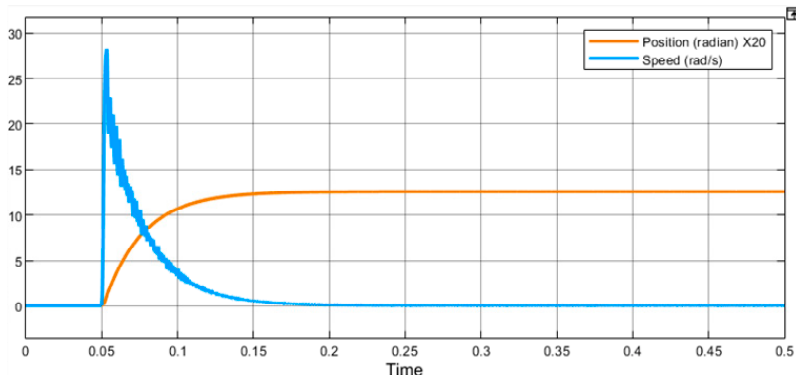
Figure 5. The position and speed response with step input command.